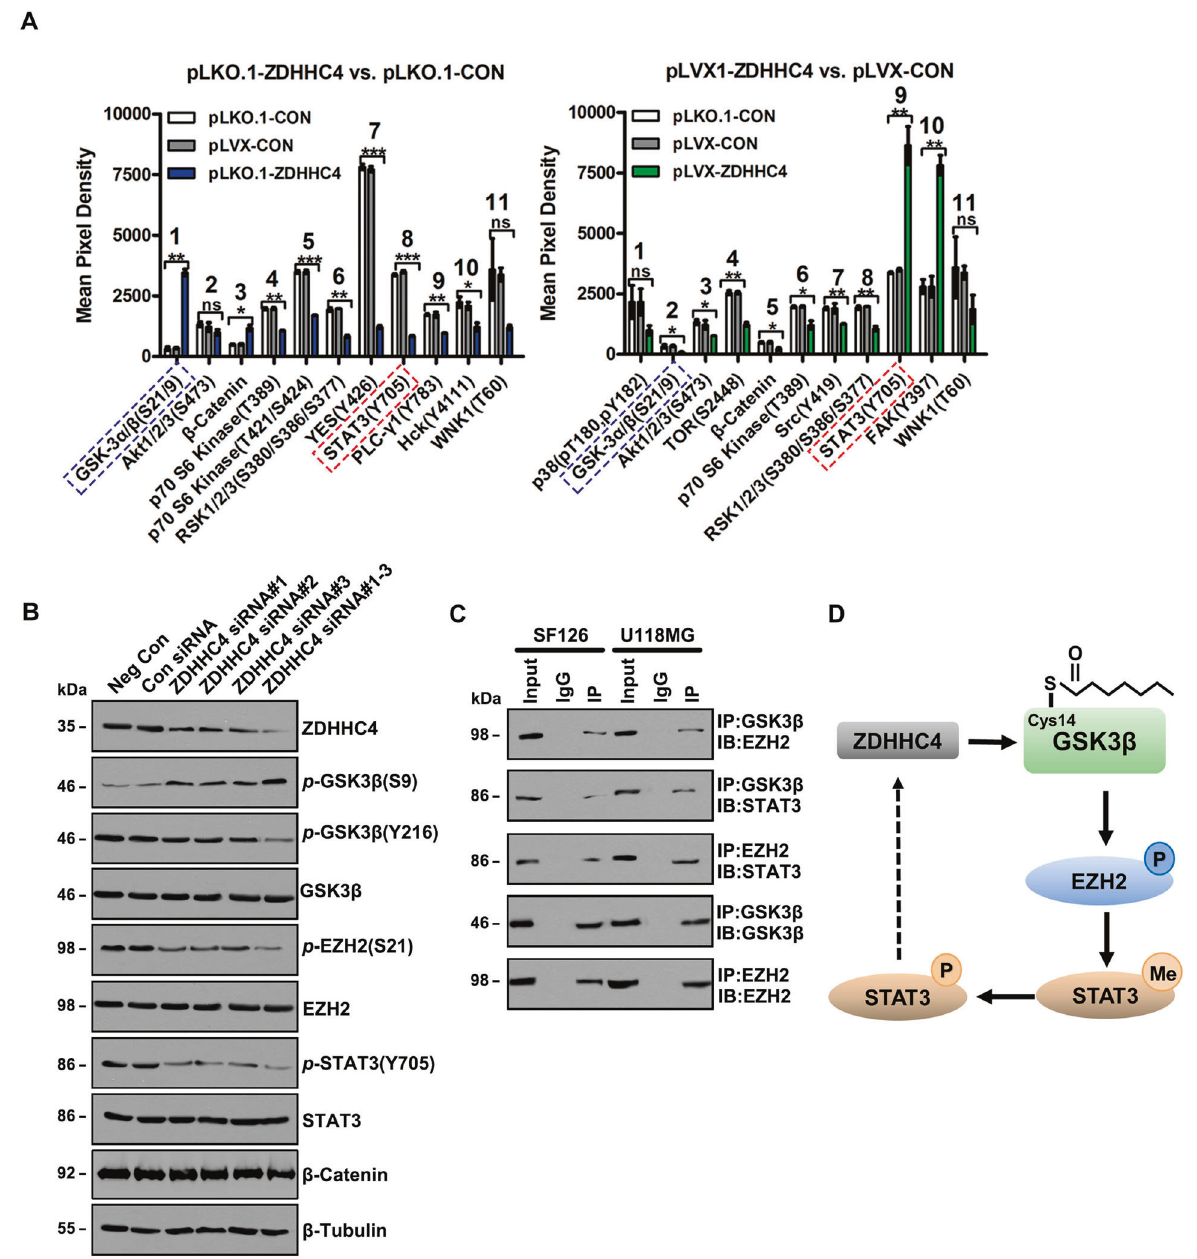
* P < 0.05; ** P < 0.01; *** P < 0.001. B Western blot analysis of the phosphorylation activity of GSK3 β , EZH2, and STAT3 after treatment with ZDHHC4 siRNA. C Immunoprecipitation was used to detect the interaction between GSK3 β , EZH2, and STAT3 in SF126 and U118 cells. D Schematic diagram of GSK3 β regulating the EZH2 – STAT3